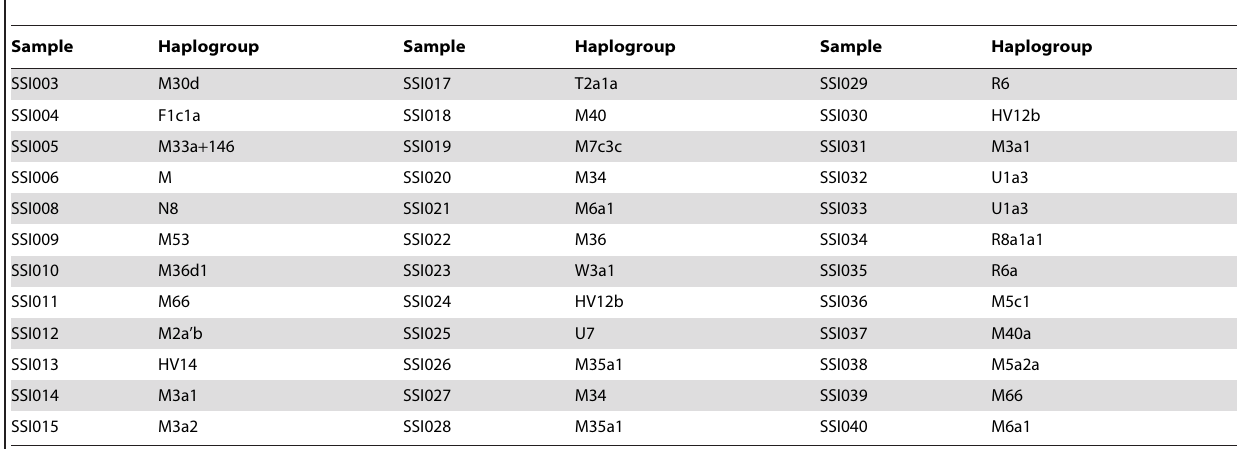
Table 2. Mitochondria haplogroup assignment for the 36 SSIP samples.